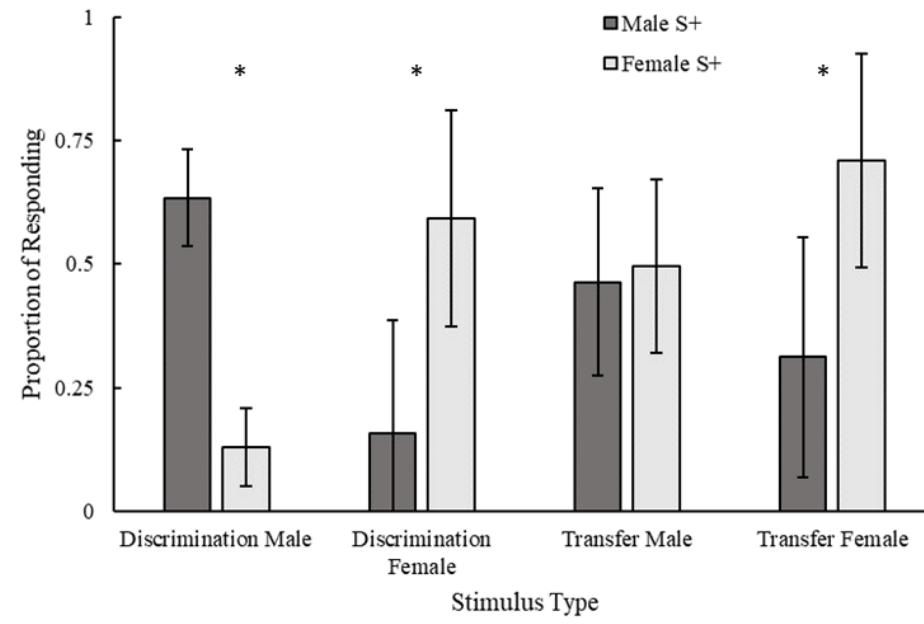
Mean ± SE Proportion of Responding to Stimuli During the Transfer Testing Stage for True Groups (e.g., Male S+ and